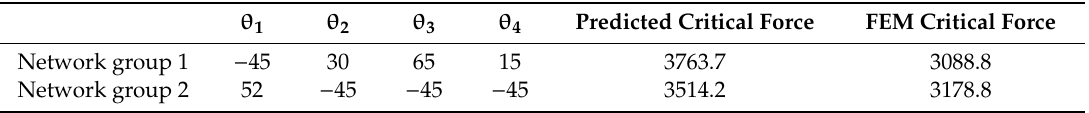
Table 9. The values of the optimum angle configurations determined for group neural network as well as the values of the predicted critical forces and obtained using FEM. θ 1 θ